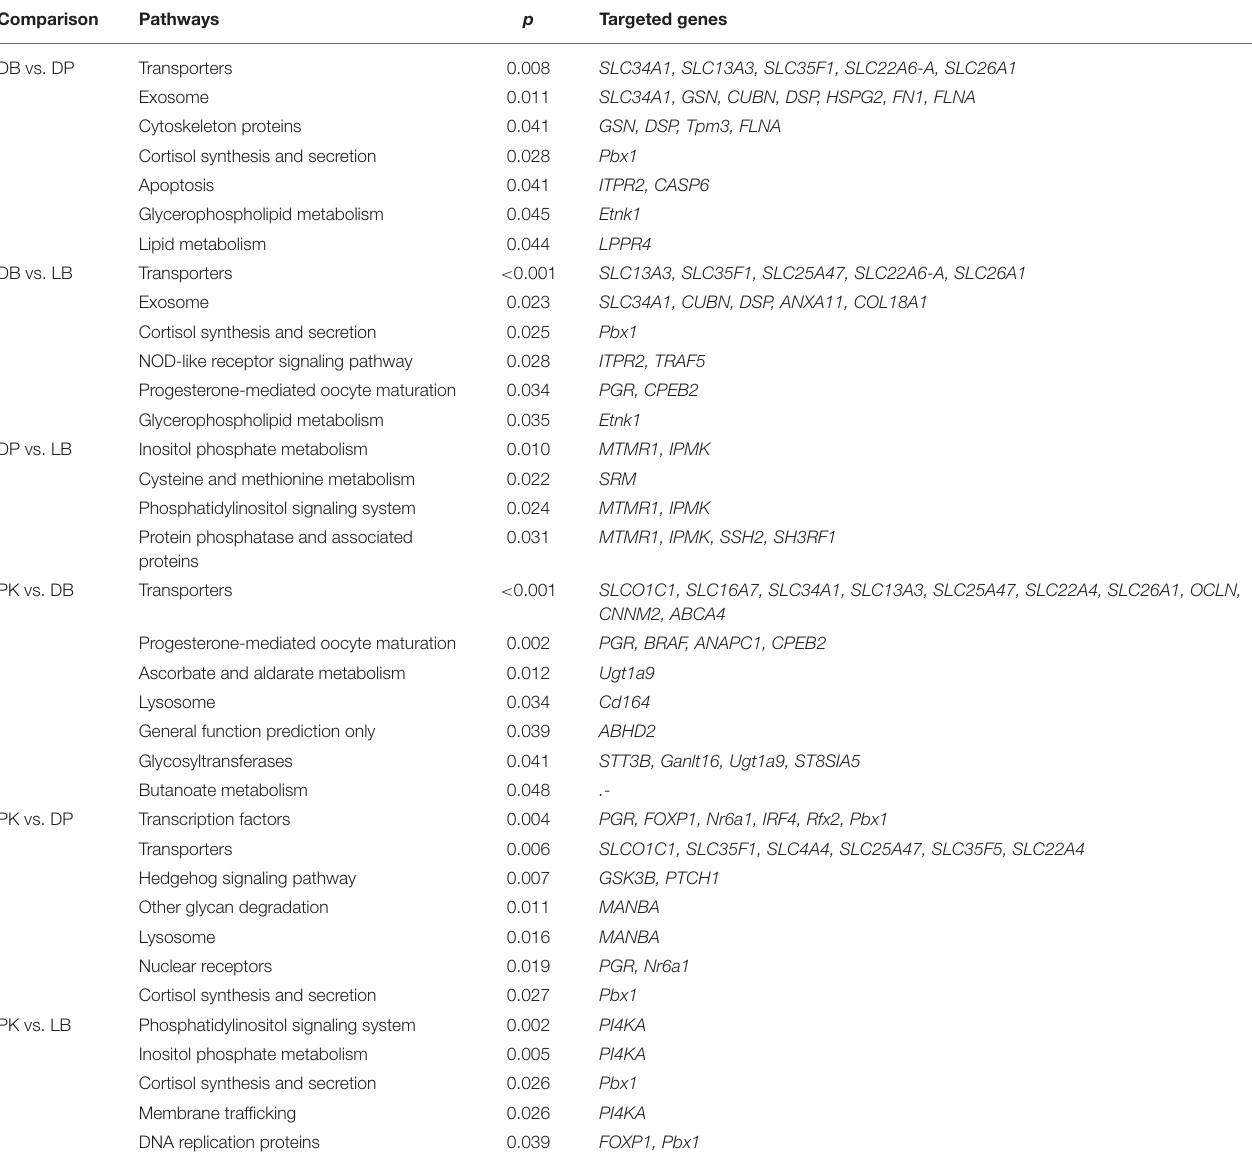
TABLE 1 | Differently enriched KEGG pathways with targeted genes of comparisons between chickens with different eggshell colors.